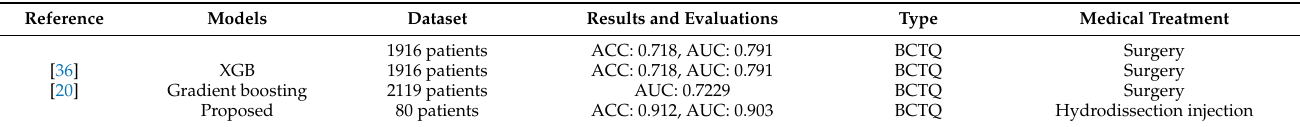
Table 6. Comparison with other work in terms of diagnosis